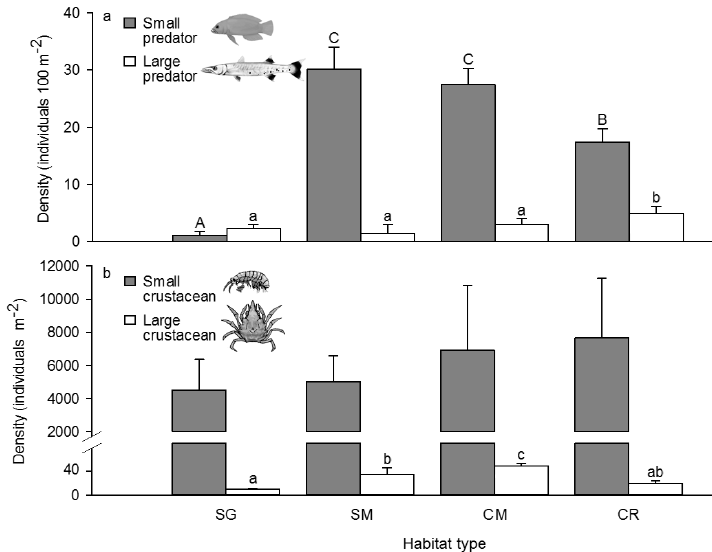
Figure 3. Distance-based redundancy analysis (dbRDA) showing the ordination of four habitat types by four target fish species’ densities in three body length categories. The abbreviations for the four habitats can be found in Table 1. The abbreviations of fish species and body length categories are La: Lethrinus atkinsoni, Lo: Lethrinus obsoletus , Lh: Lethrinus harak , and LJf: Lutjanus fulviflamma . S: Small, M: Medium, and L: Large.